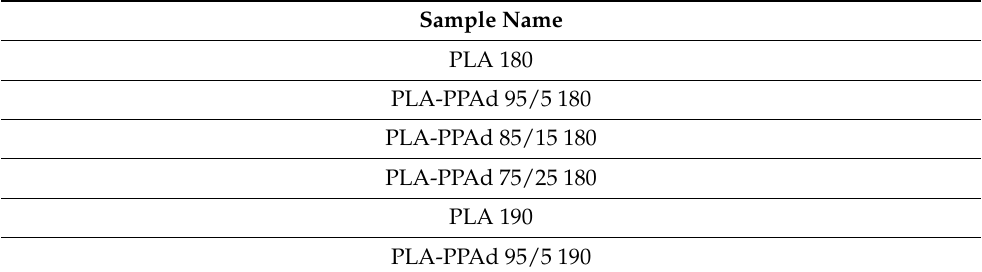
Table 1. List of the homopolymers and copolymers